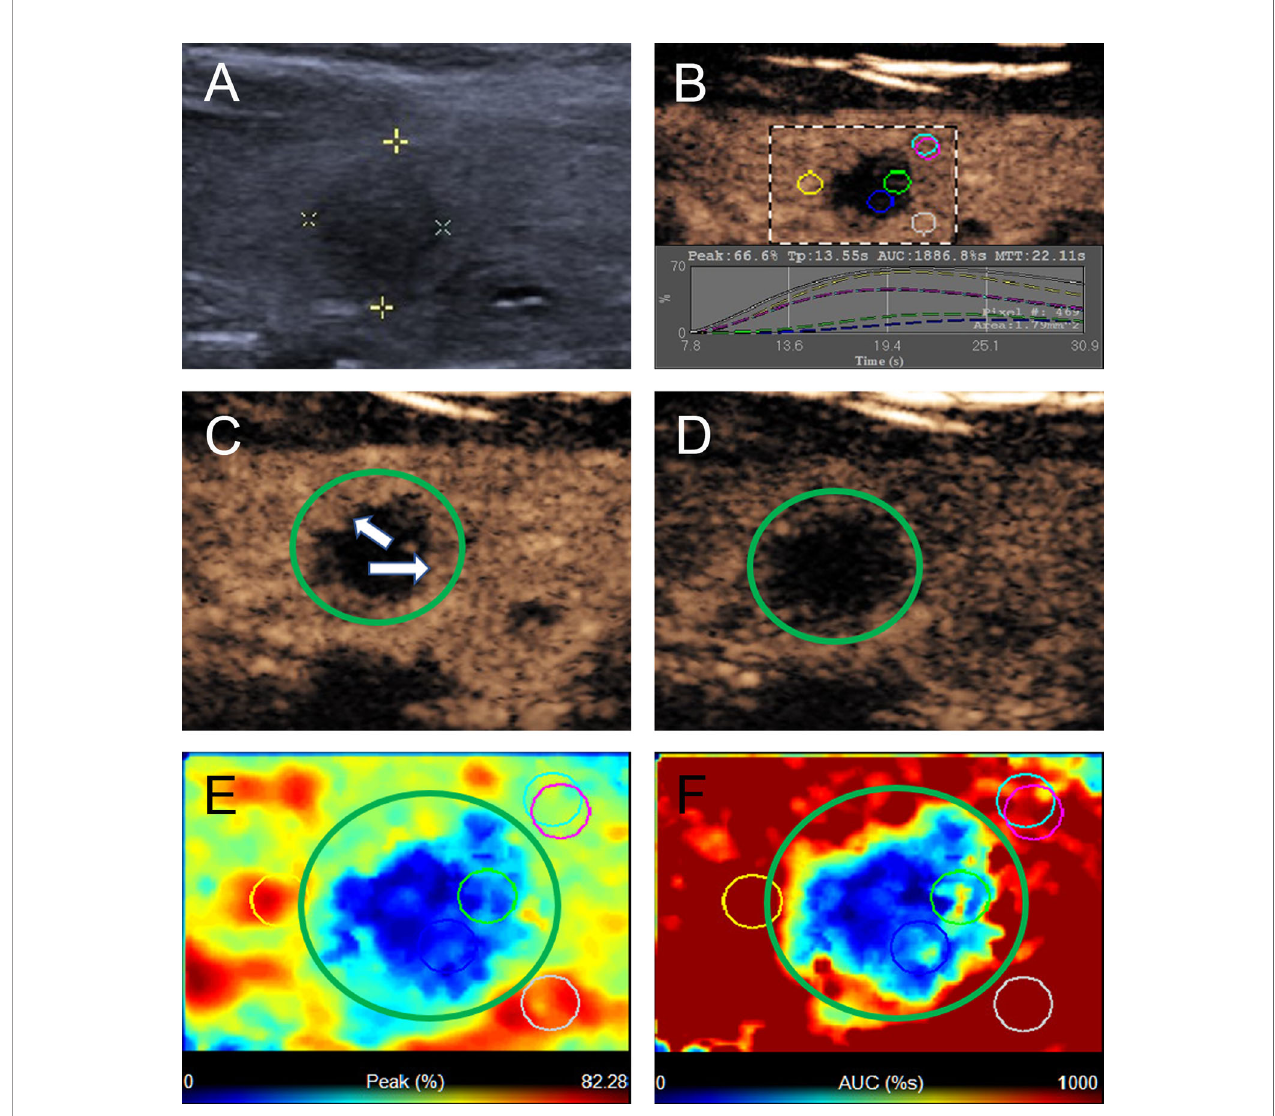
FIGURE 2 | A 40-year-old woman with A pattern mummi fi ed thyroid nodule proven by FNAB. (A) Nodule showed solid component, hypoechogenicity, ill-de fi ned margin and taller than wide shape (TI-RADS 4c). (B) Time-intensity curve showed the CEUS parameters of this nodule compared with peripheral thyroid parenchyma. (C) The early phase of CEUS showed a linear enhancement (white arrows) in the whole nodule (green circle). (D) The late phase of CEUS showed the microbubbles in the nodule fade away with a clear margin compared with peripheral thyroid parenchyma. (E) Parametric color map showed the values of peak for the nodule was totally deep blue compared with the surrounding yellow color of thyroid parenchyma, indicated the peak intensity of the nodule was markedly lower than peripheral thyroid parenchyma. (F) Parametric color map showed that the AUC for the nodule was totally deep blue with a little linear yellow on the peripheral of the nodule, indicated AUC of the nodule was obviously lower than peripheral thyroid